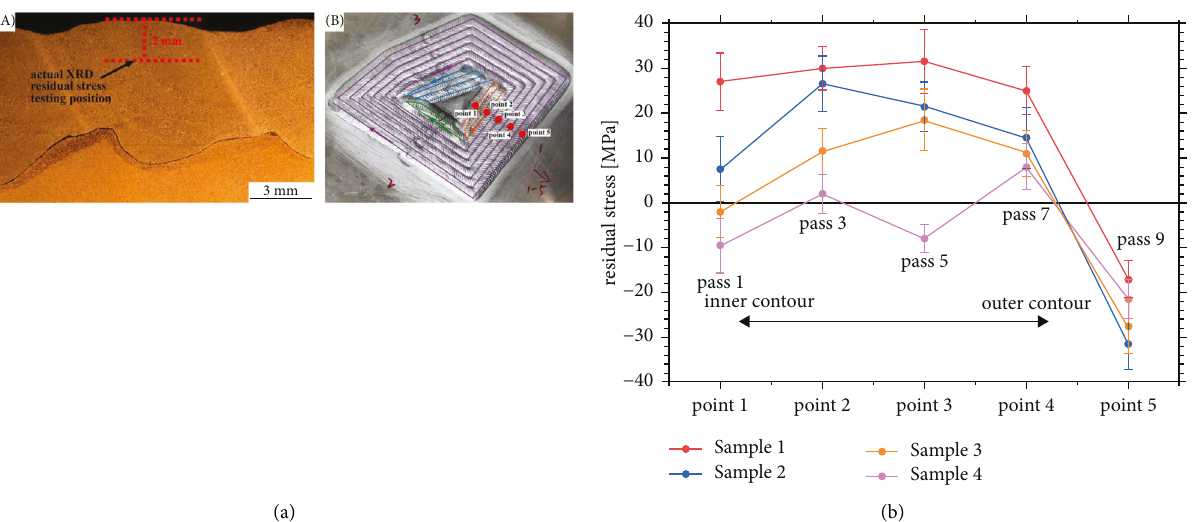
Figure 22: (a) XRD residual stress measurement point setup (taking Sample 4 as the example): (A) testing point depth location in the cross- sectional view; (B) point location in the top view. (b) XRD residual stress measurement results of Sample 1, Sample 2, Sample 3, and Sample 4 in a function of testing points from inner contour to outer contour.